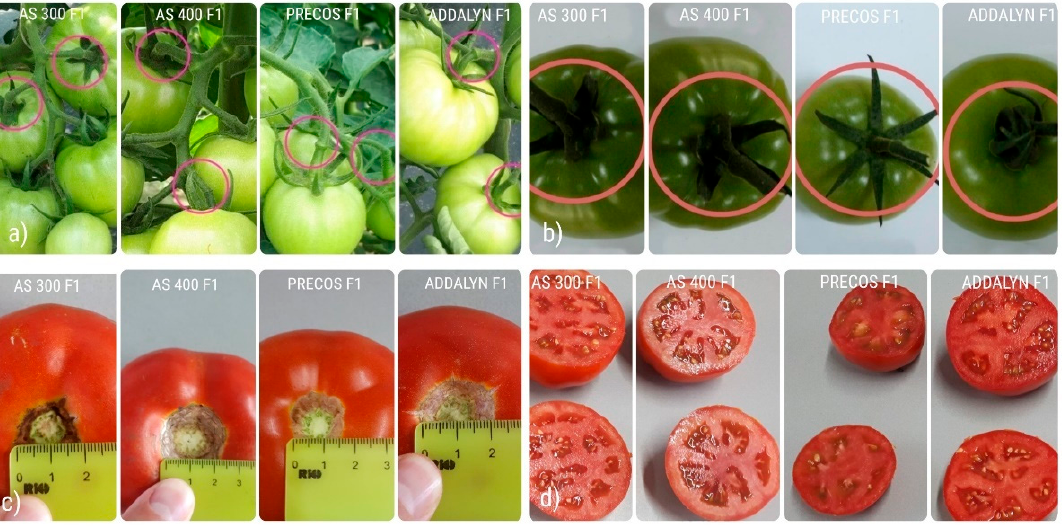
Figure 2. External quality indicators of the four tomato commercial hybrids: ( a ) distance from pedicel to calyx; ( b ) size of the calyx; ( c ) size of the peduncle scar; ( d ) number of locules.